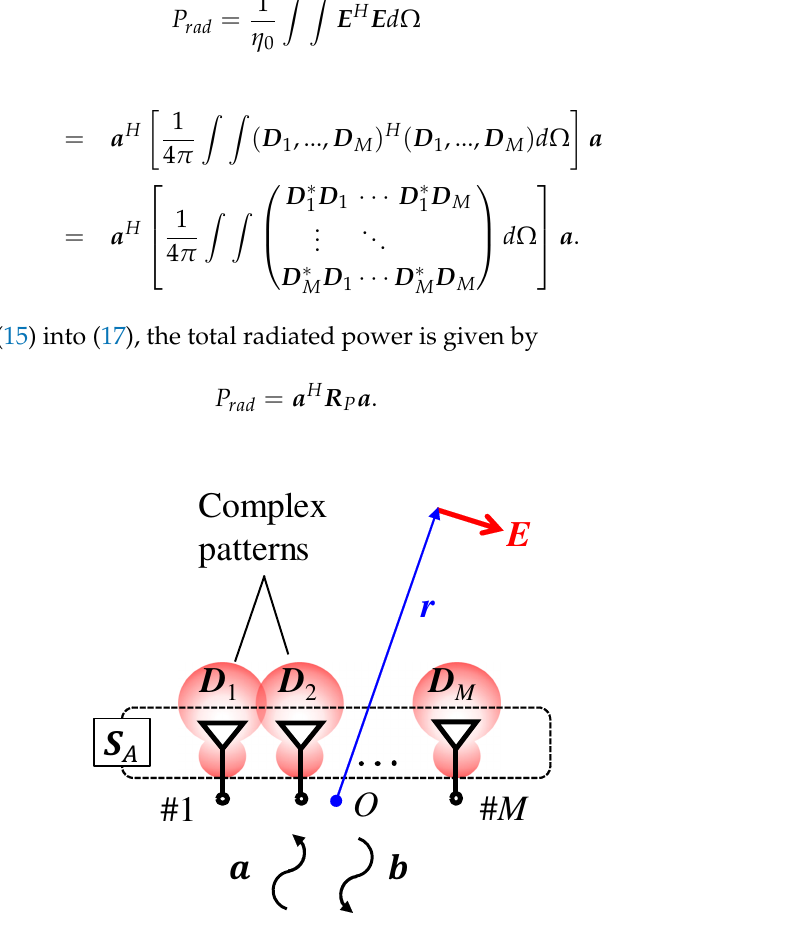
Figure 5. Lossless antenna array excited by a